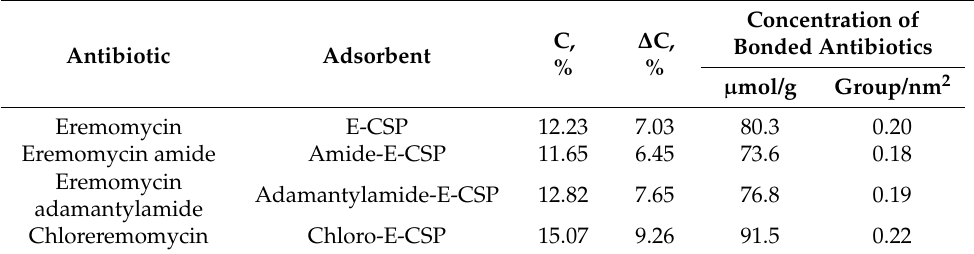
Table 1. The elemental analysis results and corresponding concentrations of glycopeptides antibiotics and their derivatives in the prepared CSP.